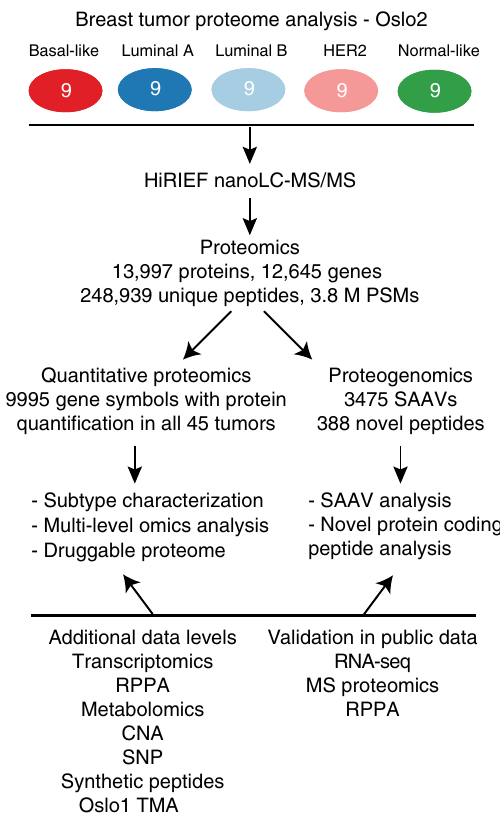
Fig. 1 Proteomics work fl ow overview. Quantitative proteome and proteogenomics analyses, and additional data levels used for validation and multi-level omics analysis. PSM peptide spectrum match, SAAV single amino acid variant, HiRIEF high-resolution isoelectric focusing, RPPA reverse phase protein array, CNA copy number alteration, SNP single- nucleotide polymorphism, TMA tissue